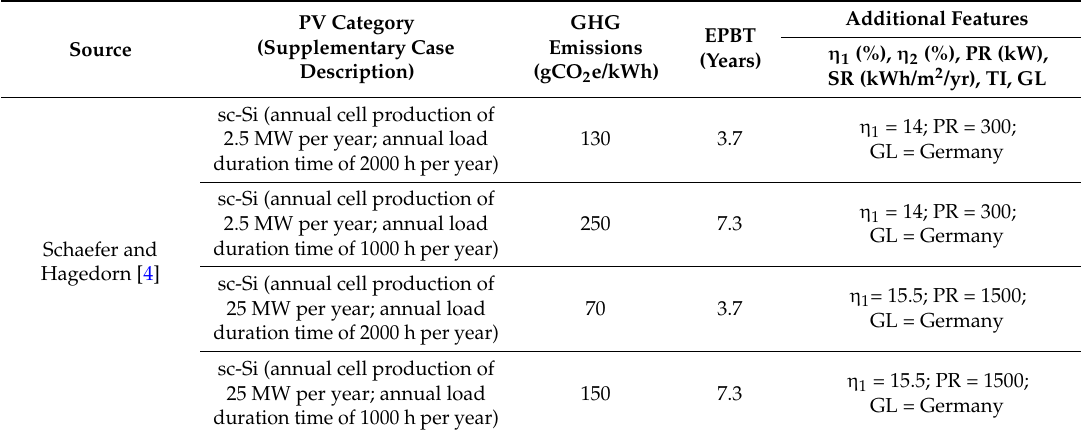
Table 1. Greenhouse Gas (GHG) emissions and Energy Pay-Back Time (EPBT) periods for photovoltaic (PV) electricity generation